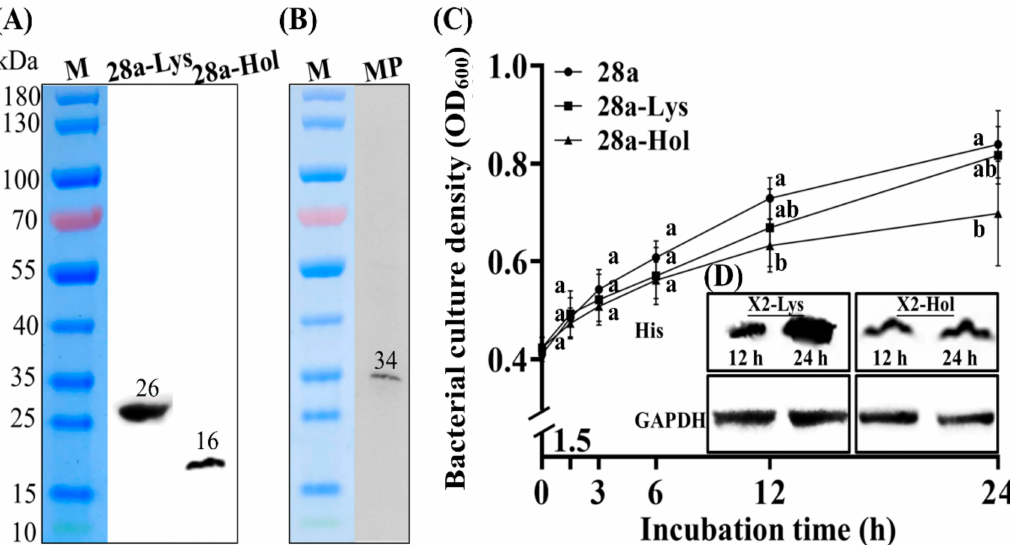
Figure 5. Subcellular localization, expression and antibacterial activity of X2-Lys and X2-Hol. ( A ) X2-Lys and X2-Hol can be expressed in vitro. ( B ) Detection of membrane proteins from E. coli BL21 transformed with pET28a-Hol. M: maker; 28a-Lys/Hol: proteins from E. coli BL21 transformed with pET28a-Lys/Hol. MP: membrane protein extract. ( C ) Bacterial growth ( n = 9). ( D ) Western blotting detection of X2-Lys and X2-Hol at 12 h and 24 h post-induction. Anti-His antibody was used to detect for target proteins, i.e: X2-Lys and X2-Hol have His tags; Antibodies against GAPDH was used as a control. Different lowercase letters represent significant difference ( p < 0.05) in bacterial culture density among the three groups of 28a, 28a-Lys and 28a-Hol at the same time